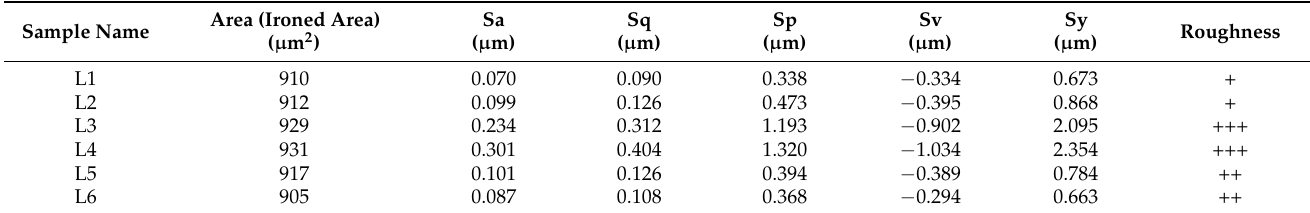
Table 3. Roughness results from the AFM